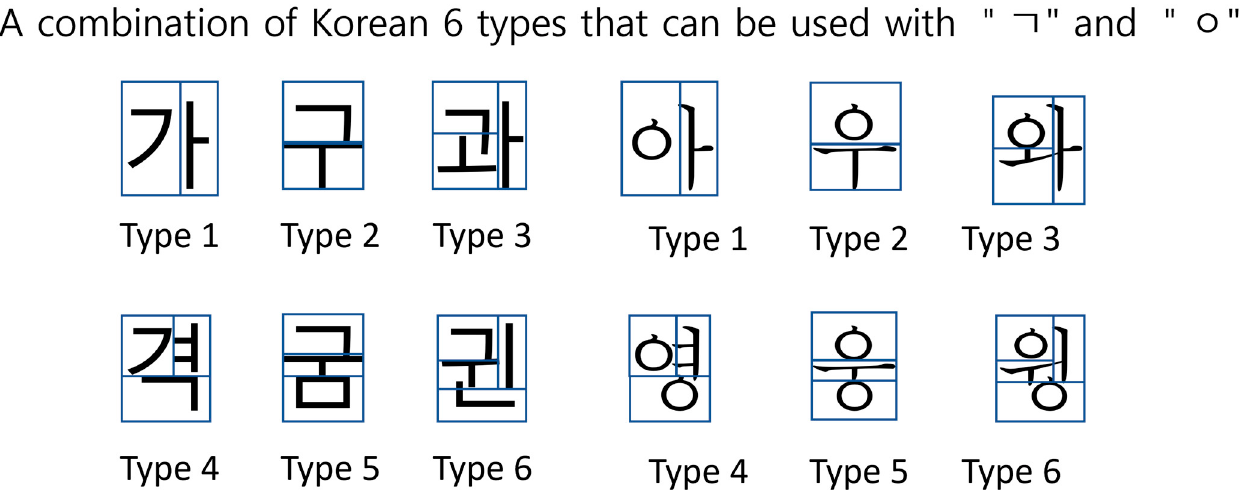
Figure 4. Six types of Korean alphabet combinations.